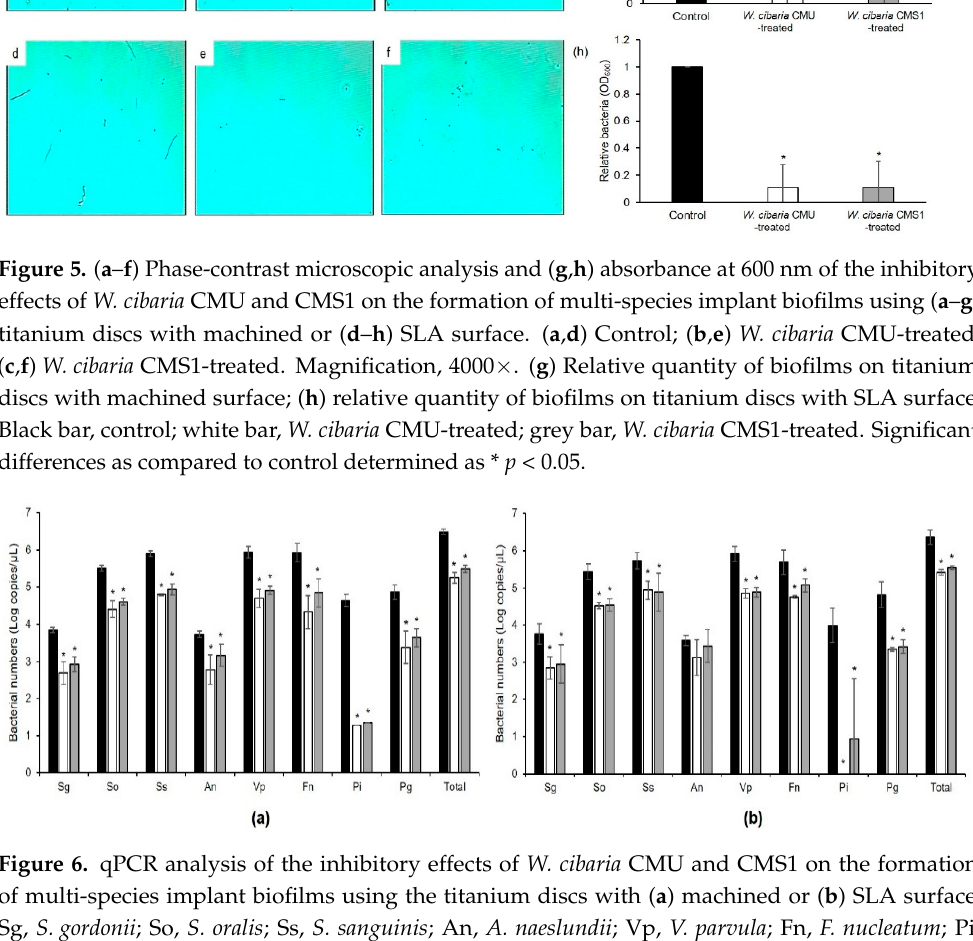
Figure 6. qPCR analysis of the inhibitory effects of W. cibaria CMU and CMS1 on the formation of multi-species implant biofilms using the titanium discs with ( a ) machined or ( b ) SLA surface. Sg, S. gordonii ; So, S. oralis ; Ss, S. sanguinis ; An, A. naeslundii ; Vp, V. parvula ; Fn, F. nucleatum ; Pi, P. intermedia ; Pg, P. gingivalis . Total, total bacteria. Black bar, control; white bar, W. cibaria CMU-treated; grey bar, W. cibaria CMS1-treated. Significant differences as compared to control determined as * p < 0.05.